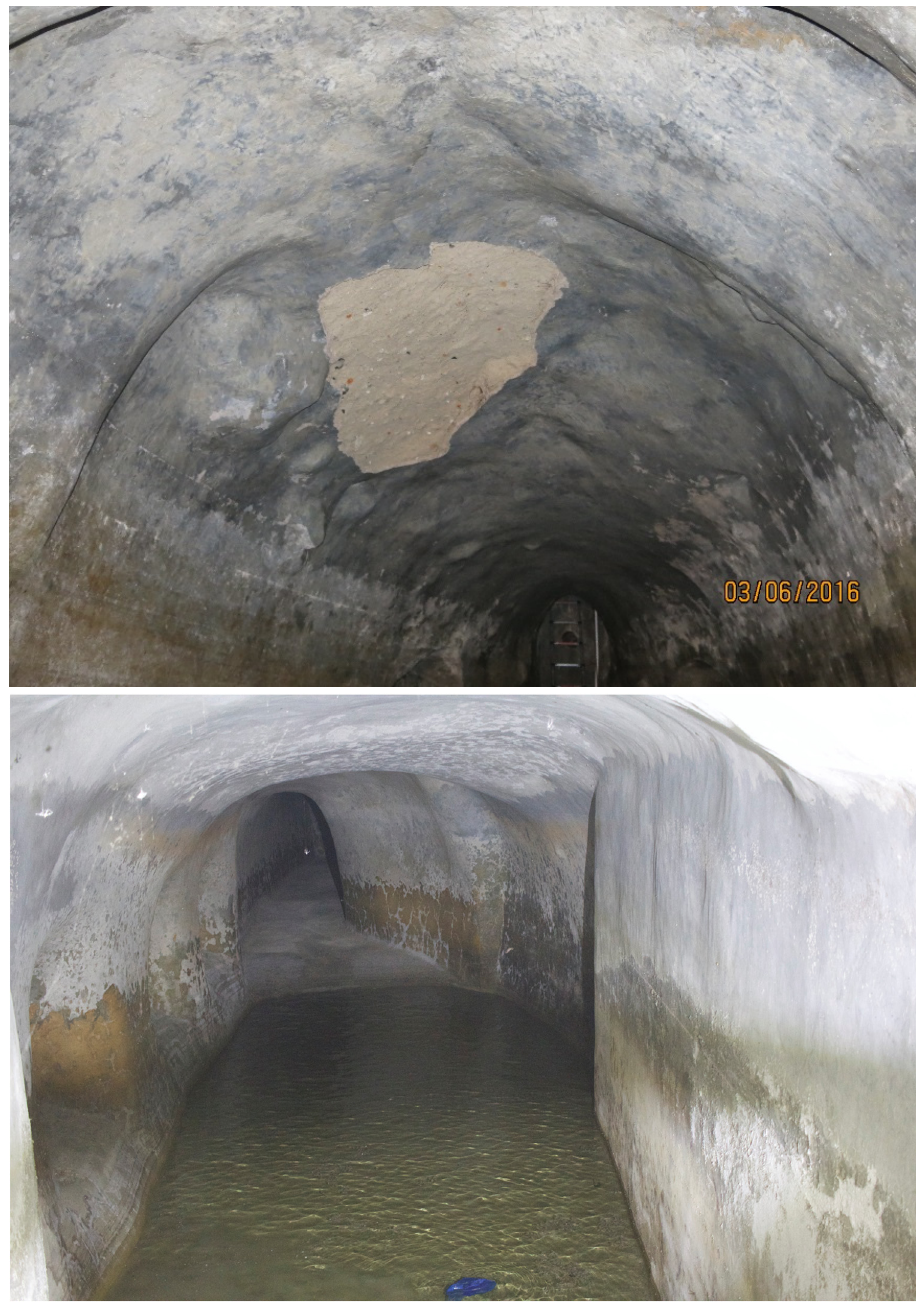
Figure 6. Damaged section of liner inside the water closet cistern in Pyrgos ( top ). Structurally sound conditions at the Exo Gonia cistern near Art Space ( bottom ). Photos taken by Nikos